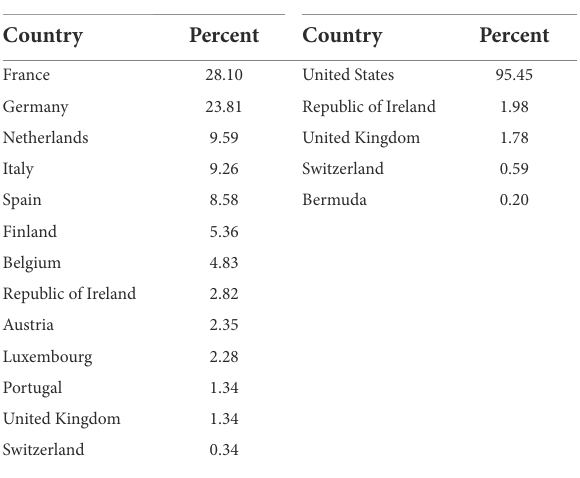
TABLE 1 Sample by countries.